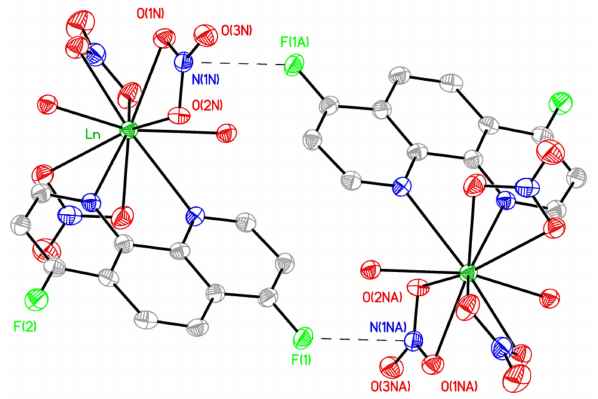
Figure 10. Centrosymmetric dimers assembled via F . . . NO 3 interaction. The amide groups are omitted for clarity.